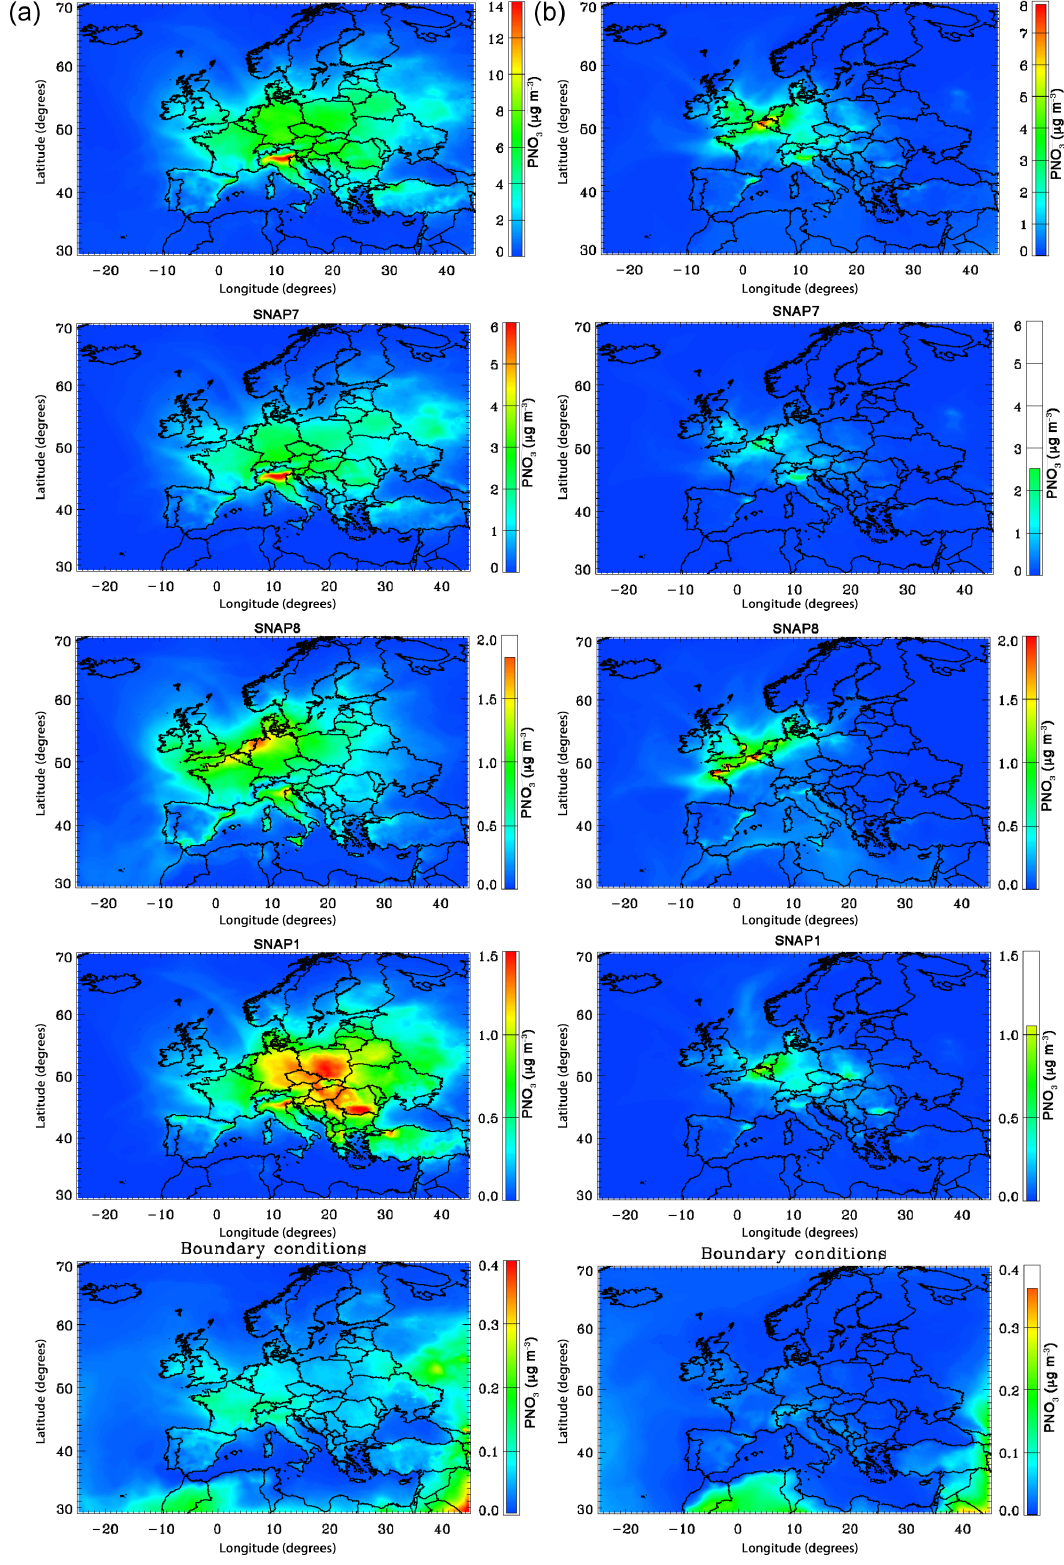
Figure 2. Average concentrations of PNO 3 (top panels) and contributions from road transport (SNAP7), ships (SNAP8), combustion in energy and transformation industries (SNAP1), and boundary conditions in February–March 2009 (a) and in June 2006 (b)